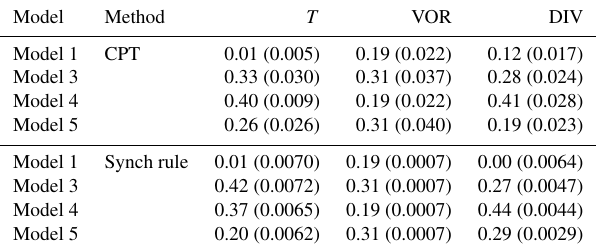
Figure 10. Forecast quality as measured by the RMSE of the truth and a model with a perturbed initial condition. The control is the difference between the perfect model and the perfect model with a perturbed initial condition. Table 4. Weights for the supermodel trained by CPT and the synch rule. Between brackets, the standard deviation over the year (CPT) or the standard deviation over the last 10 weeks of training (synch rule) is